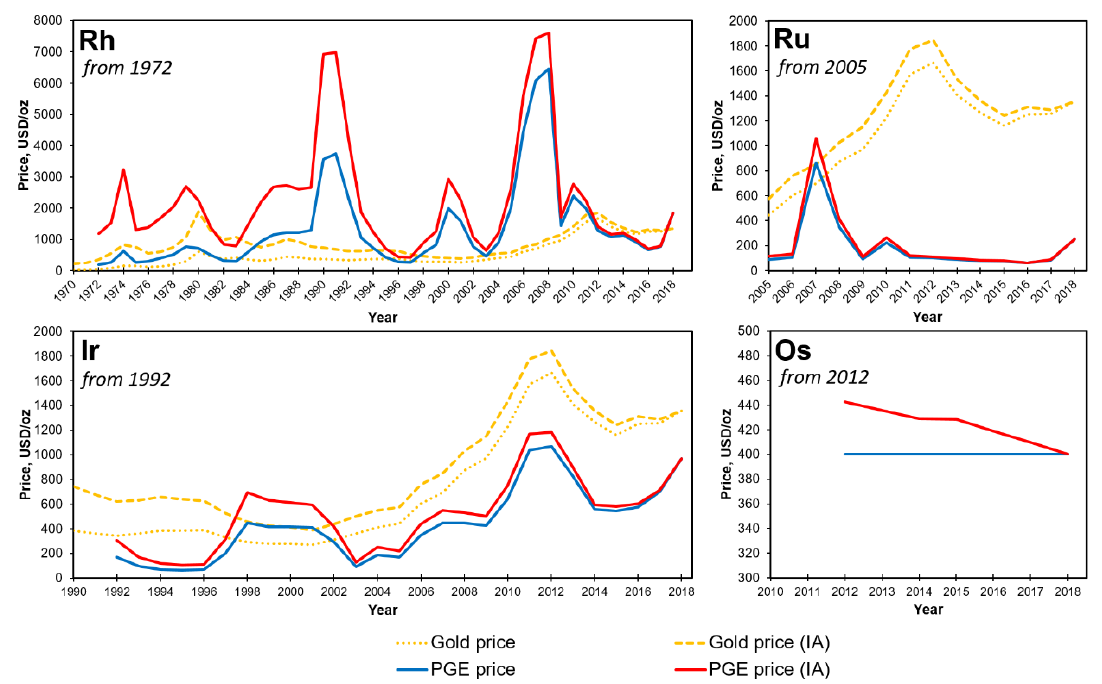
Figure 6. The price of Rh, Ir, Ru, and Os versus the gold price and inflation (IA — inflation-adjusted) [74,75].